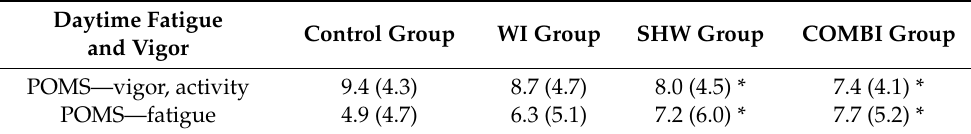
Table 4. Daytime fatigue and